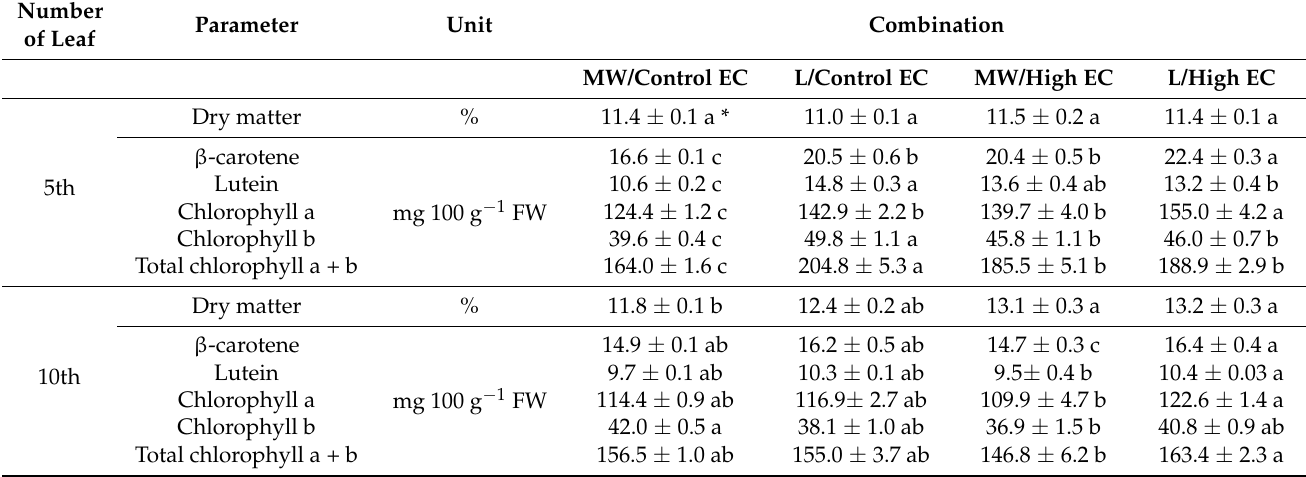
Table 2. Dry matter content and photosynthetic pigment in leaves of cucumber plants (average from two